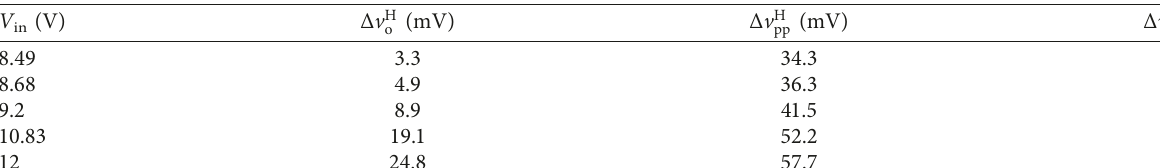
Figure 6: Output voltage ripple of the DCPT-controlled buck converter. (a) The case of 2 P Table 3: The output voltage ripple of the DCPT-controlled buck